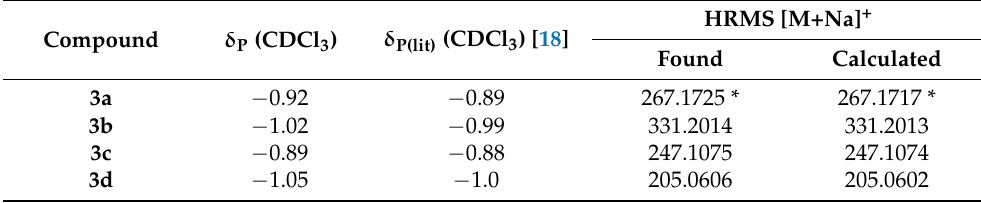
Table 7. The identification of known trialkylphosphates ( 3a – d